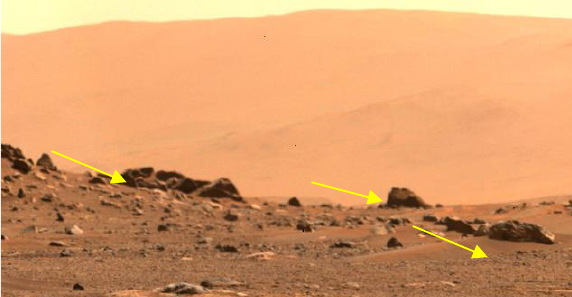
Figure 19. Mastcam-Z image recorded on Sol 4. Several big boulders can be seen.